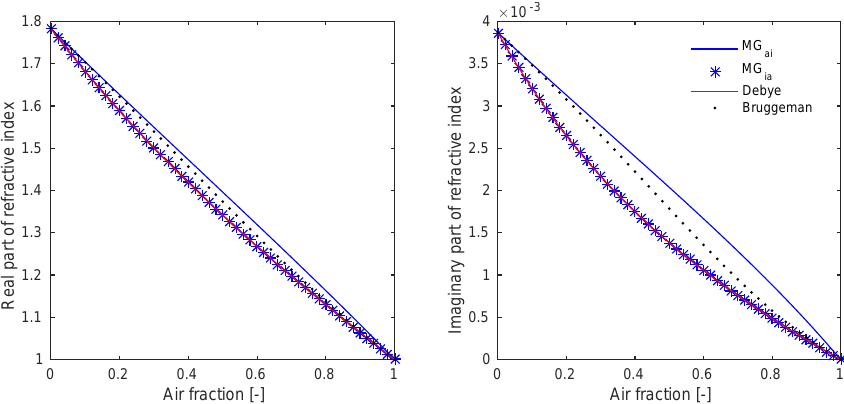
Figure 2. Real (left) and imaginary (right) part of the effective refractive index of a mixture of ice and air as a function of air volume fraction according to some mixing rules. The refractive index of ice at 183GHz and 263K, n ice = 1 . 7831 + i 0 . 0039, was used, and the refractive index of air was set to n air = 1 + i